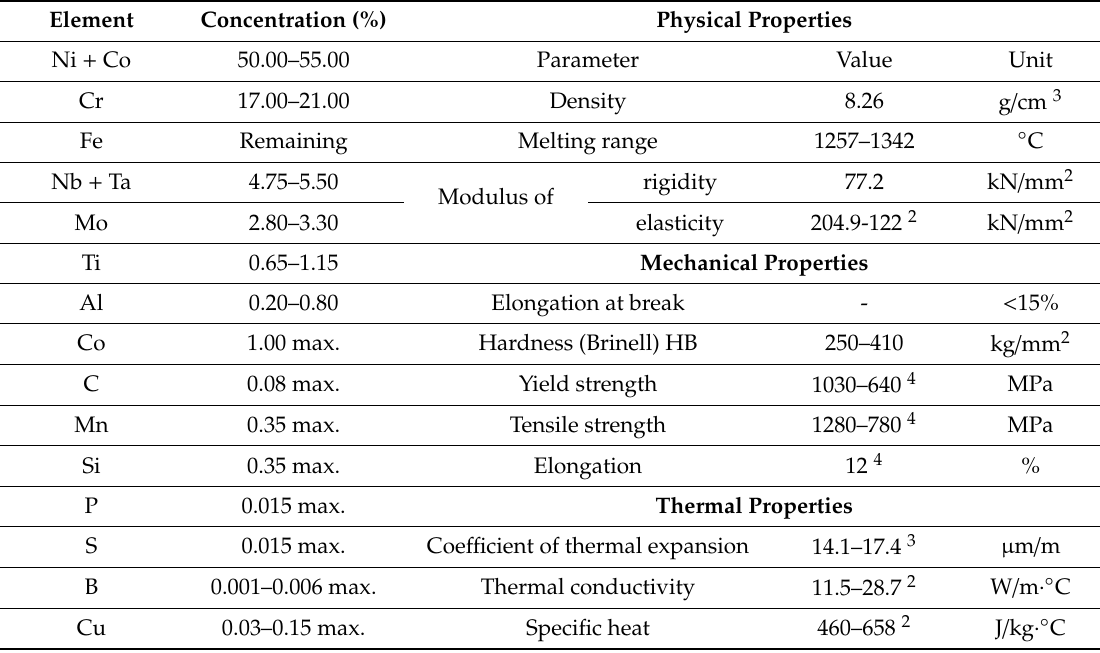
Table 5. Chemical composition of INCONEL ® alloy 718 1 , as well as its selected physical, mechanical, and thermal properties.